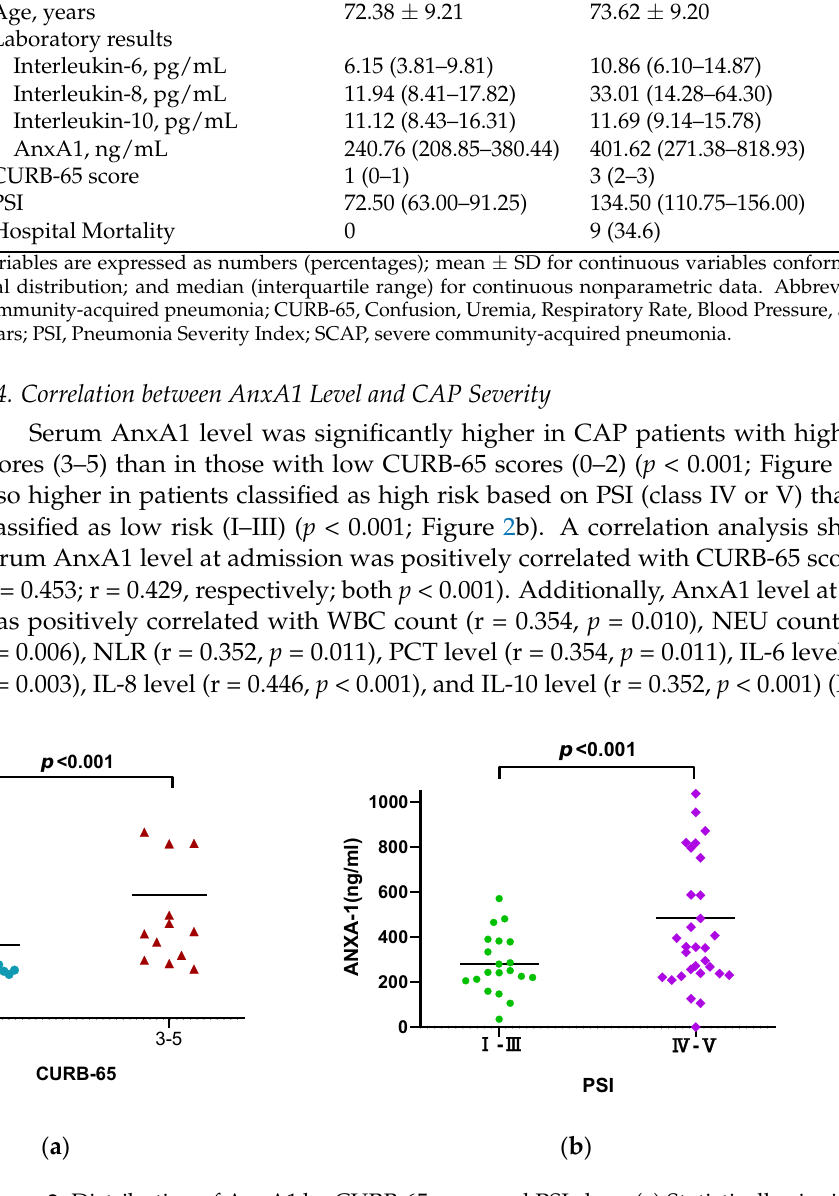
Figure 2. Distribution of AnxA1 by CURB ‐ 65 score and PSI class. ( a ) Statistically significant differences in AnxA1 level were observed among CAP patients according to the CURB ‐ 65 score. ( b ) AnxA1 level distinguished patients with high ‐ risk PSI (classes IV and V). Each point represents the median value.